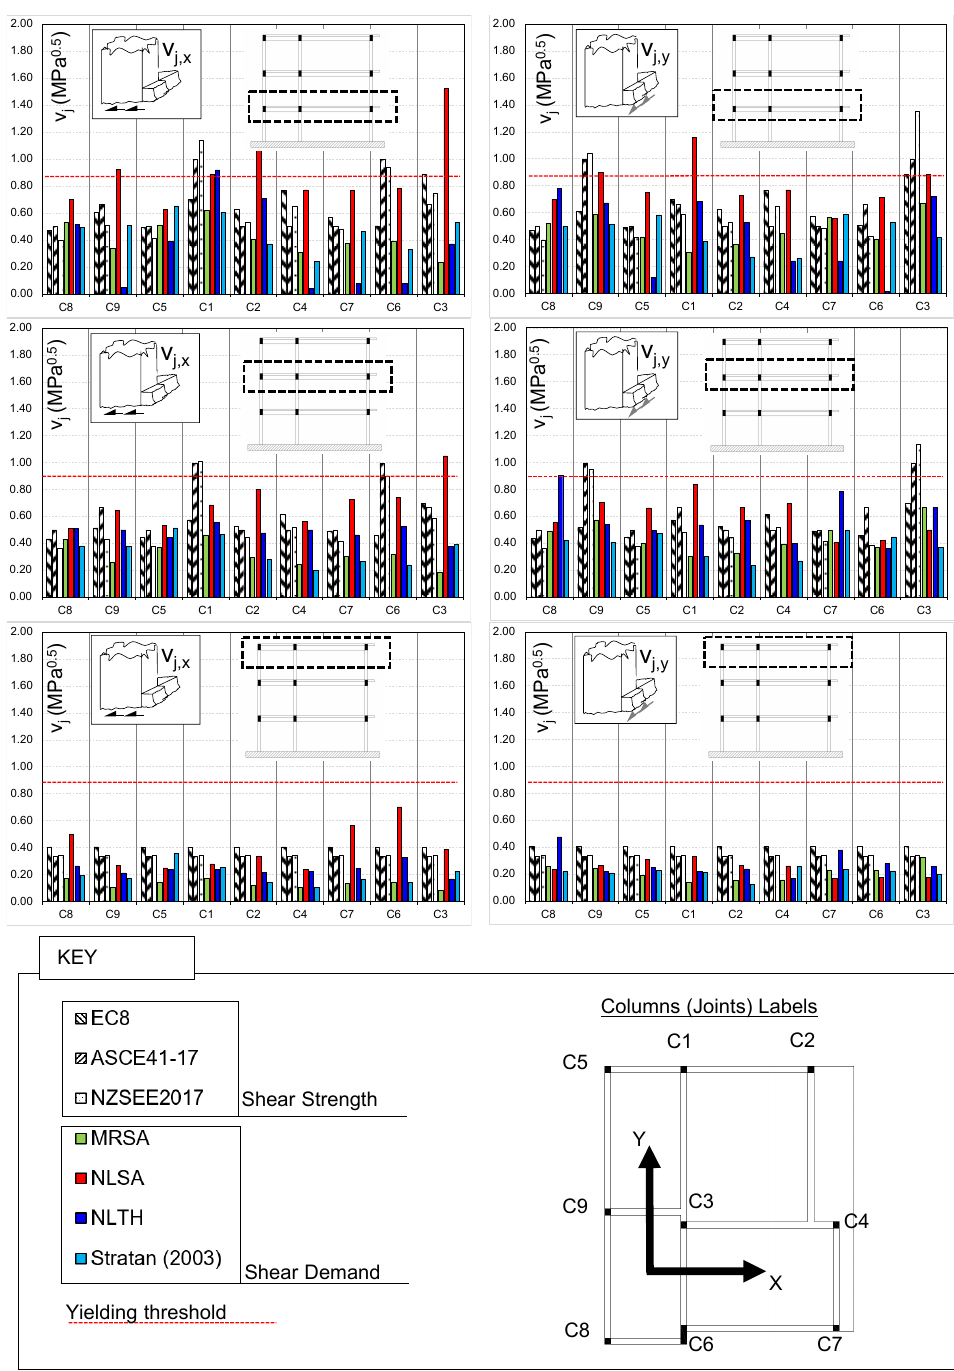
Figure 17. Evaluated joint shear demand and strength for beam–column joints of SPEAR frame. The reader is referred to the color version of this